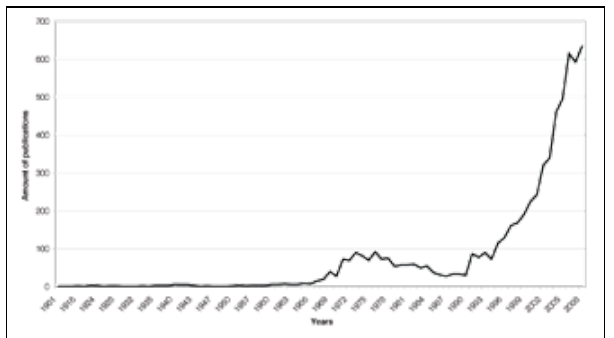
Fig. 1. Publications relating to cannabis in the ISI-Web database, 1900 - 2008.